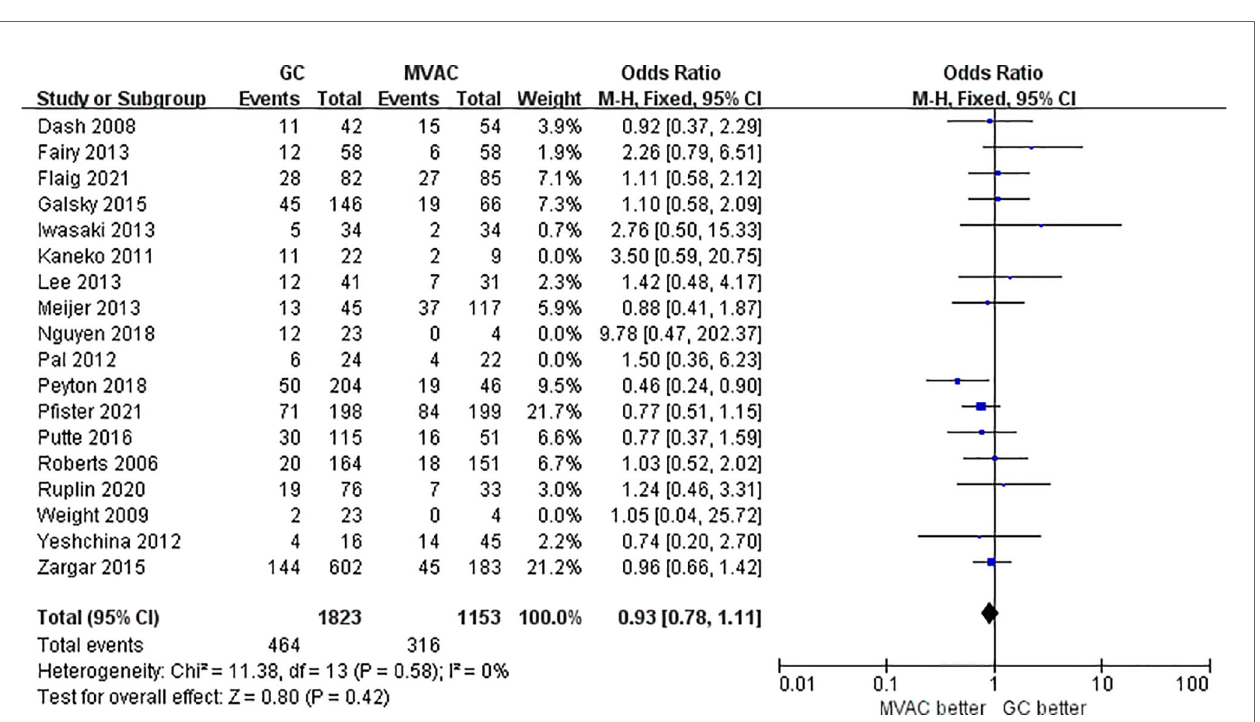
FIGURE 4 | Forest plot of pathological complete response (PCR) to GC versus MVAC after removing studies with small sample